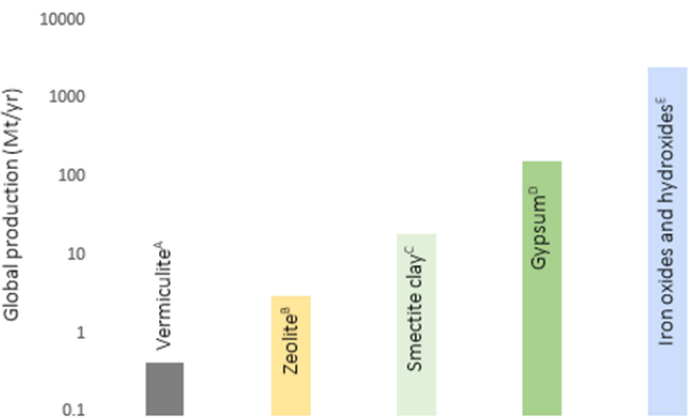
Figure 5. Global production quantities for main minerals reviewed in this paper. Note: these are estimated production quantities not reserves, as USGS (United States Geological Survey) reports that reserve estimates for most minerals are not known. References: A = [157], B = [158], C = [159], D = [160], and E = [161].